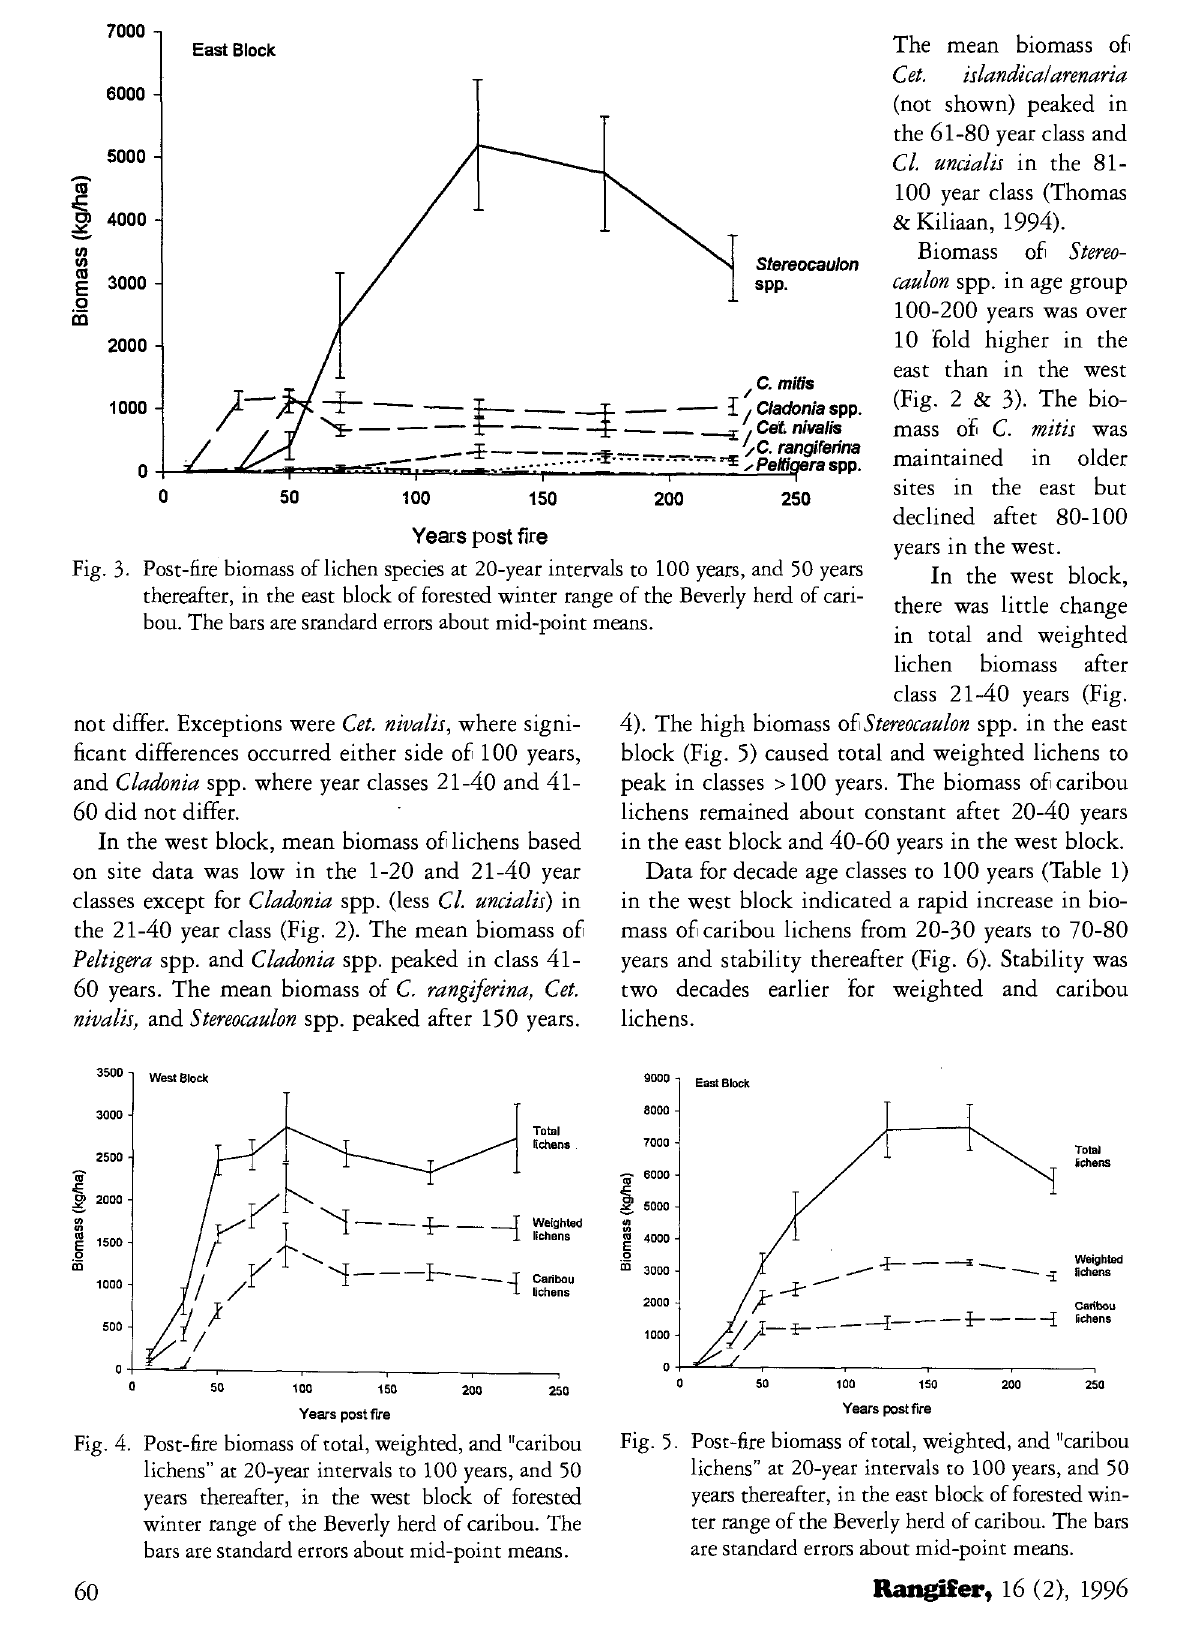
Fig. 4. Post-fire biomass of total, weighted, and "caribou lichens" at 20-year intervals to 100 years, and 50 years thereafter, in the west block of forested winter range of the Beverly herd of caribou. The bars are standard errors about mid-point means.